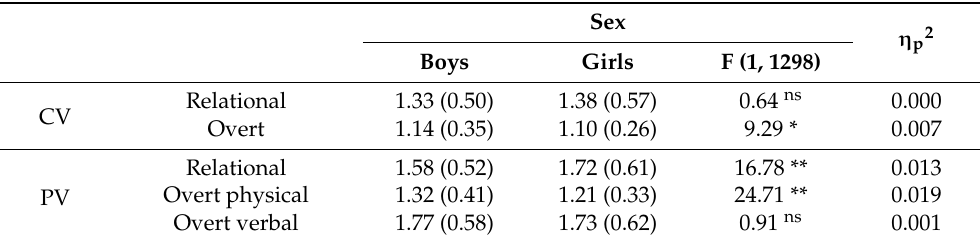
Table 3. Means, standard deviations and ANOVA results between sex, cybervictimization (CV) and peer victimization (PV).